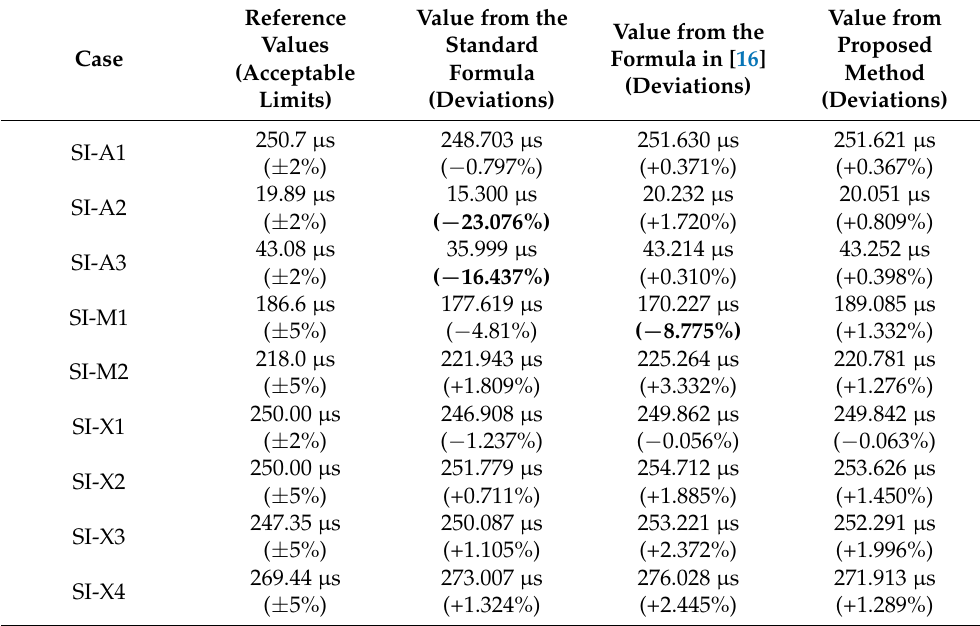
Table 1. Reference and calculated values, acceptable limits, and deviations of T p .